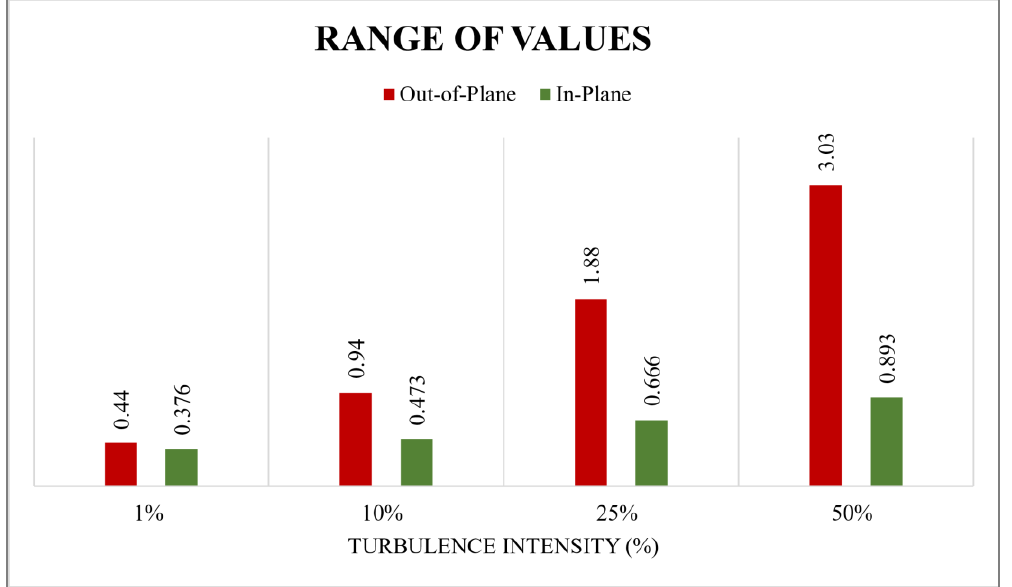
Figure 18. Range of Values of the Blade